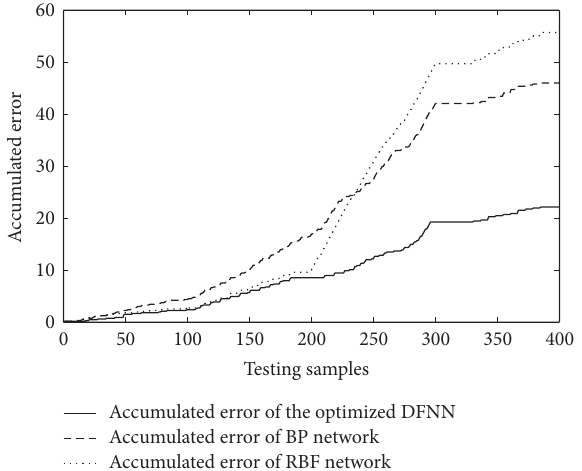
Figure 18: Testing accumulated errors of three networks.